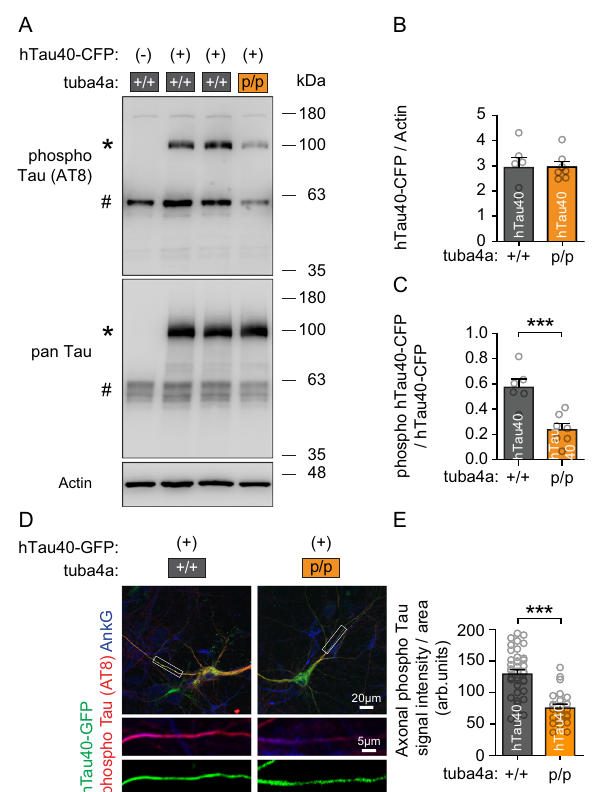
Fig. 6 Hyper-phosphorylation of human Tau is normalized upon the loss of Tuba4a C-terminal polyglutamylation. A Western blot of mock- or adeno virus-transduced CFP-tagged human Tau (hTau40-CFP) using DIV19 neurons from Tuba4a Δ polyGlu ( + / + ) and (p/p) mice after 2 days of expression. AT8: phosphorylated Tau-speci fi c antibody. pan-Tau: total Tau. Loading control: Actin. Note, endogenous mouse Tau (#) and the human CFP-Tau fusion protein (*) are distinguishable based on their different molecular weights. The representative western blots shown in ( A ) are derived from three independent experiments. B hTau40-CFP signal intensities normalized to actin. n = 6( + / + ), 7(p/p) cultures per genotype. C Phospho-hTau40-CFP signal intensities normalized to total Tau, as shown in ( A ). n = 6( + / + ), 7(p/p) cultures per genotype. D Representative immunostaining of phosphorylated Tau (AT8, red), using DIV10 hippocampal neurons derived from Tuba4a Δ polyGlu ( + / + ) and (p/p) mice, 2 days after transfection of hTau40-GFP constructs (green signals). Scale bars, 20 µ m (overview) and 5 µ m (magni fi cation). Ankyrin-G (AnkG, blue) was used as an axonal marker. E Quanti fi cation of phosphorylated Tau signal intensities normalized to the axonal area analyzed, as shown in ( D ). n = 41( + / + ), 25(p/p) cells per genotype. Arbitrary units (arb. units). A two-sided unpaired Student´s t-test was used to asses statistical signi fi cance. *** p < 0.001. Data represent mean ± SEM. Source data, including exact p-values, are provided as a Source Data fi